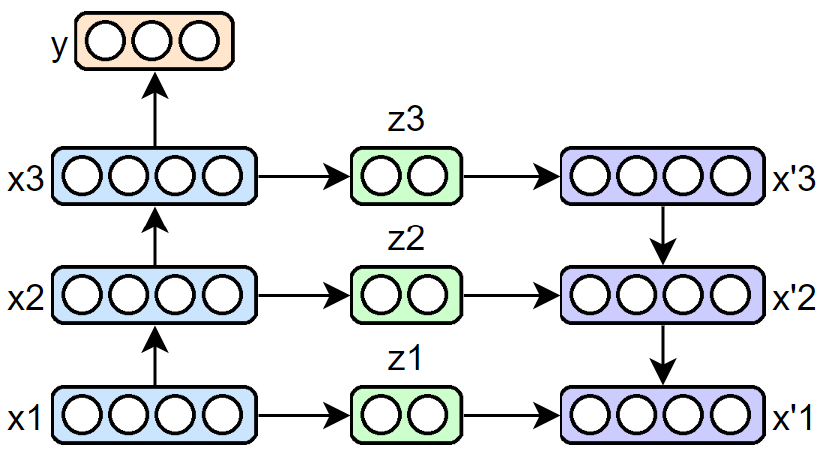
Figure 2. DHRNet conceptual architecture.